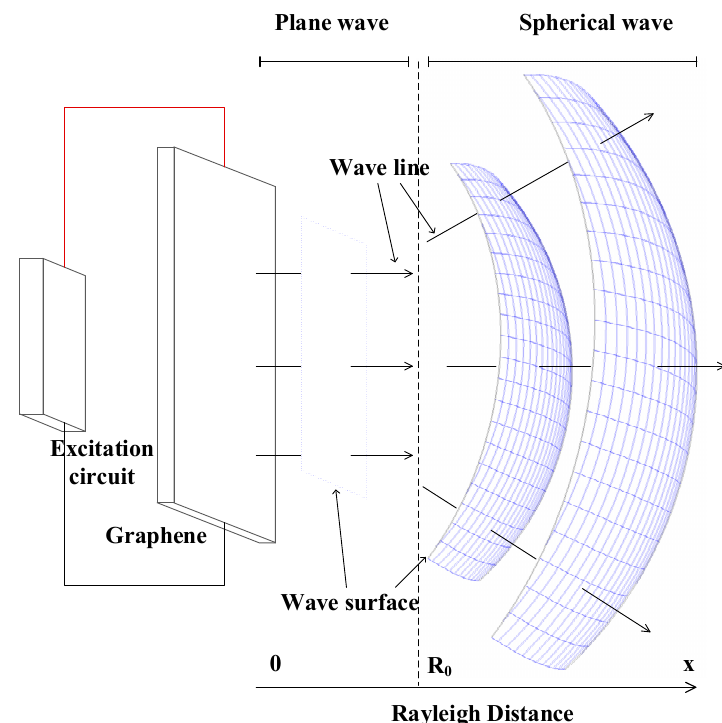
Figure 1. The working principle of thermoacoustic speaker. The AC excitation and the DC bias excitation are respectively expressed as